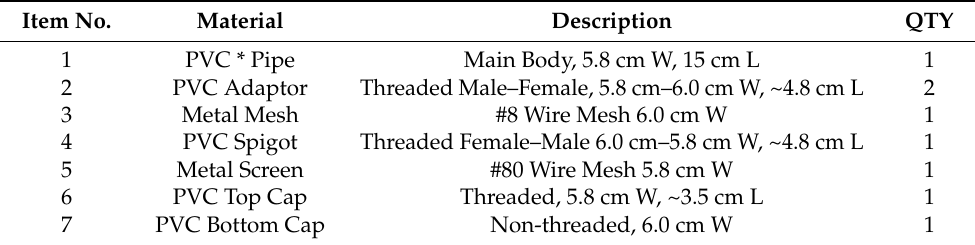
Figure 1. Schematic of the components comprising a Varroa Shaker Device (VSD) and how to assemble the components. The numbers correspond to the item numbers listed in Table 1. Table 1. List and descriptions of materials needed for building a Varroa Shaker Device (VSD). All polyvinyl chloride (PVC) components are schedule 40 (i.e., ~0.4 cm wall thickness). All width (W) measurements given are for the inner diameter; L = length of